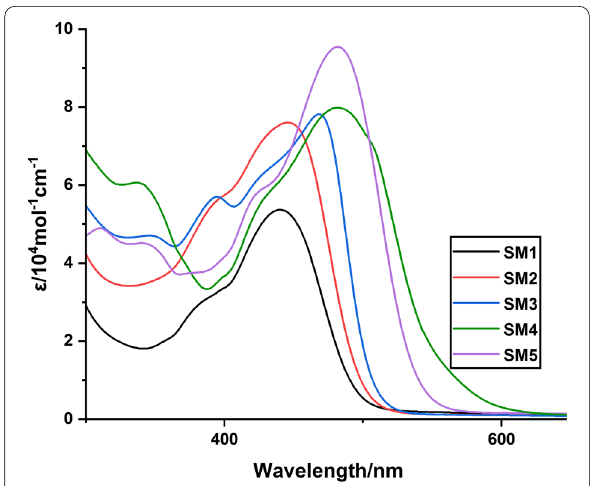
Fig. 5 UV–Vis absorption spectra of SM1-5 measured in DMF (2 10 –5 M) × Table 1 Absorption data for sensitizers SM1-5 Sensitizer Absorption λ max